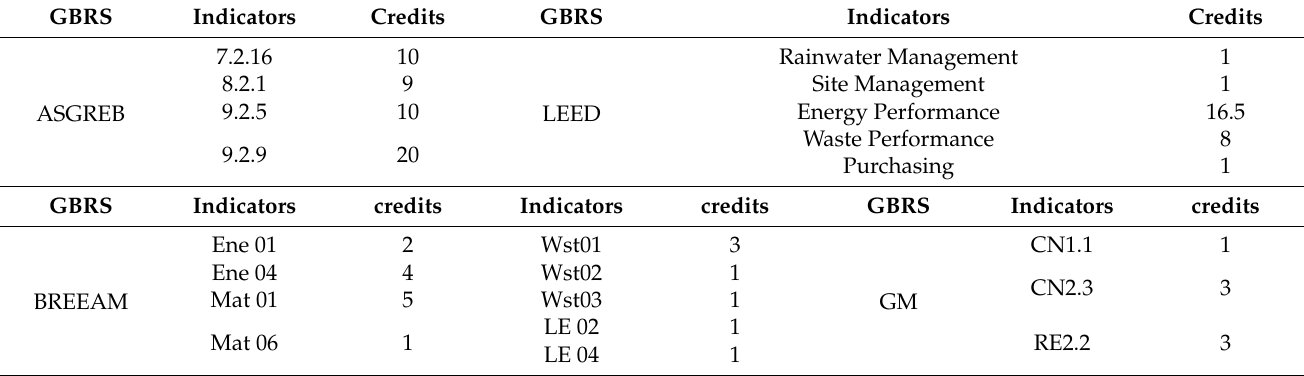
Table 11. Innovation scope CO 2 -related indicators